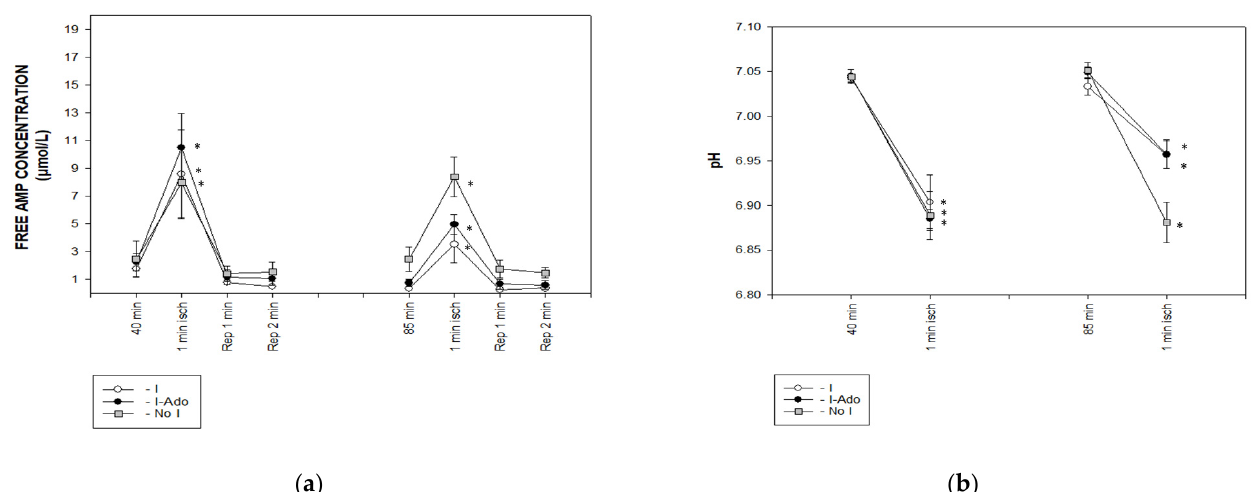
Figure 5. The 31 P NMR spectra based calculation of ( a ) free AMP concentration and ( b ) pH before, during, and after 1 min ischemia in hearts subjected to 1 min ischemia at 40 min of perfusion, 10 min ischemia at 50 min of perfusion, and 1 min ischemia at 85 min of perfusion without (Group I) or with (Group I-Ado) supply of adenosine at 30 µ M concentration during the first 15 min of reperfusion and in control hearts (Group No I) subjected three times to 1 min ischemia at 40, 50, and 85. Values are mean ± SEM ( n = 5–9). * p < 0.05 vs. value before ischemia.